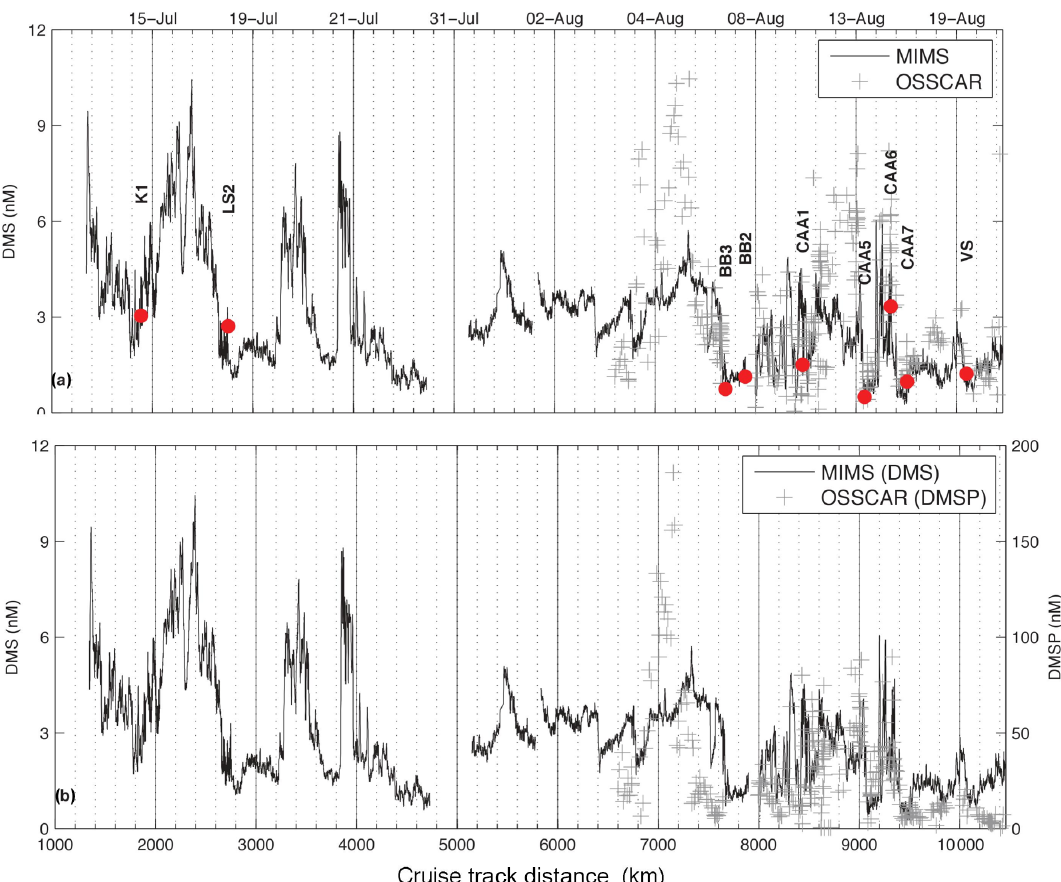
Figure 3. Distribution of DMS and DMSP along the cruise track. Panel (a) shows DMS measurements made by MIMS and OSSCAR. Note that a small fraction (less than 0.5%) of measurements made by OSSCAR were above 12nM. Panel (b) shows MIMS data with OSSCAR DMSP measurements superimposed on a different y scale (right-hand side). Labelled red dots indicate DMS concentrations measured at discrete sampling stations (see Table